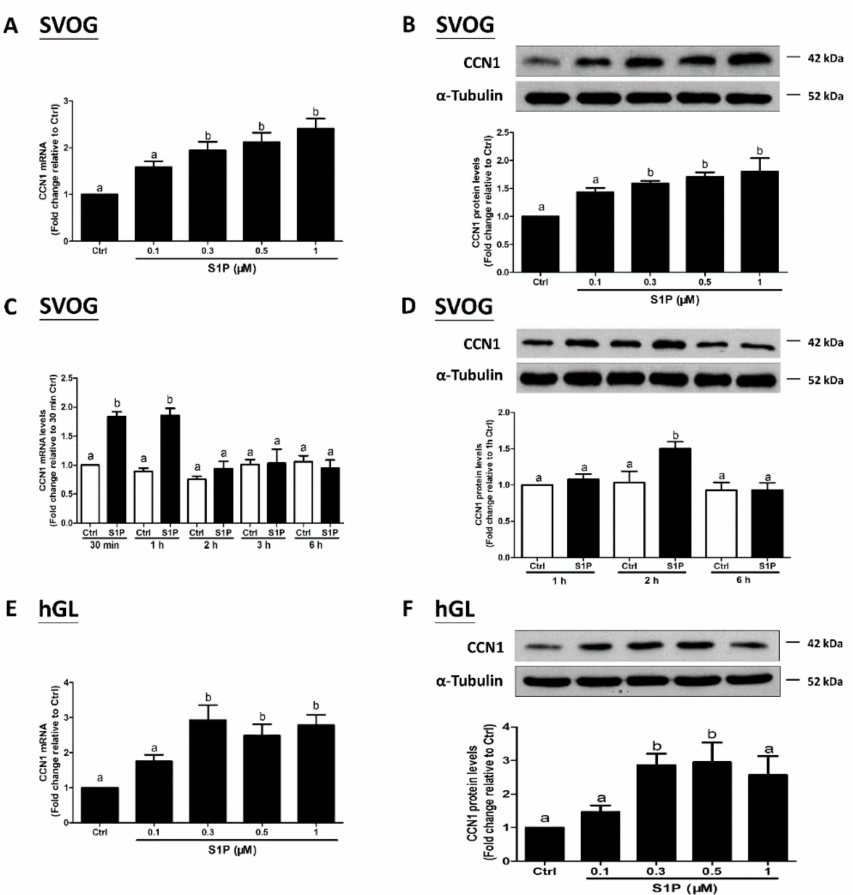
Figure 1. Sphingosine-1-phosphate (S1P) induces the expression of CCN1 in human granulosa-lutein cells. Immortalized human granulosa-lutein (SVOG) cells were treated with a vehicle control (PET solution containing 5% polyethylene glycol, 2.5% ethanol, and 0.8% Tween-80) or increasing concentrations (0.1, 0.3, 0.5, or 1 µ M) of S1P for 1 h ( A ) or 2 h ( B ). The mRNA and protein levels of CCN1 were examined using RT-qPCR ( A ) and western blot analysis ( B ), respectively. SVOG cells were treated with a vehicle control or 0.3 µ M S1P for various periods of time (30 min, 1 h, 2 h, 3 h, or 6 h); the mRNA and protein levels of CCN1 were examined using RT-qPCR ( C ) and western blot analysis ( D ), respectively. primary human granulosa-lutein (hGL) cells were treated with a vehicle control or increasing concentrations (0.1, 0.3, 0.5, and 1 µ M) of S1P for 1 h ( E ) or 2 h ( F ). The mRNA and protein levels of CCN1 were examined using RT-qPCR ( E ) and western blot analysis ( F ), respectively. The results are presented as the mean ± SEM of at least three independent experiments. If a pair of values is significantly di ff erent ( p < 0.05), the values have di ff erent subscript letters (a vs. b or b vs. c) assigned to them. Ctrl, control; S1P,